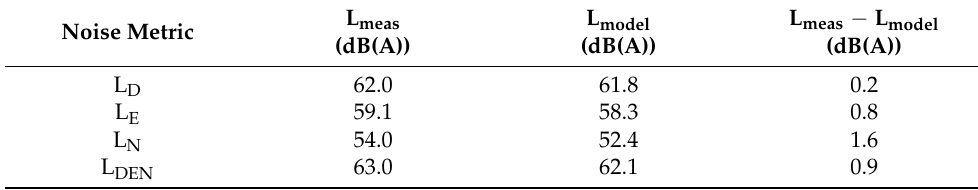
Table 10. Noise levels according to measurements and pass-by model.